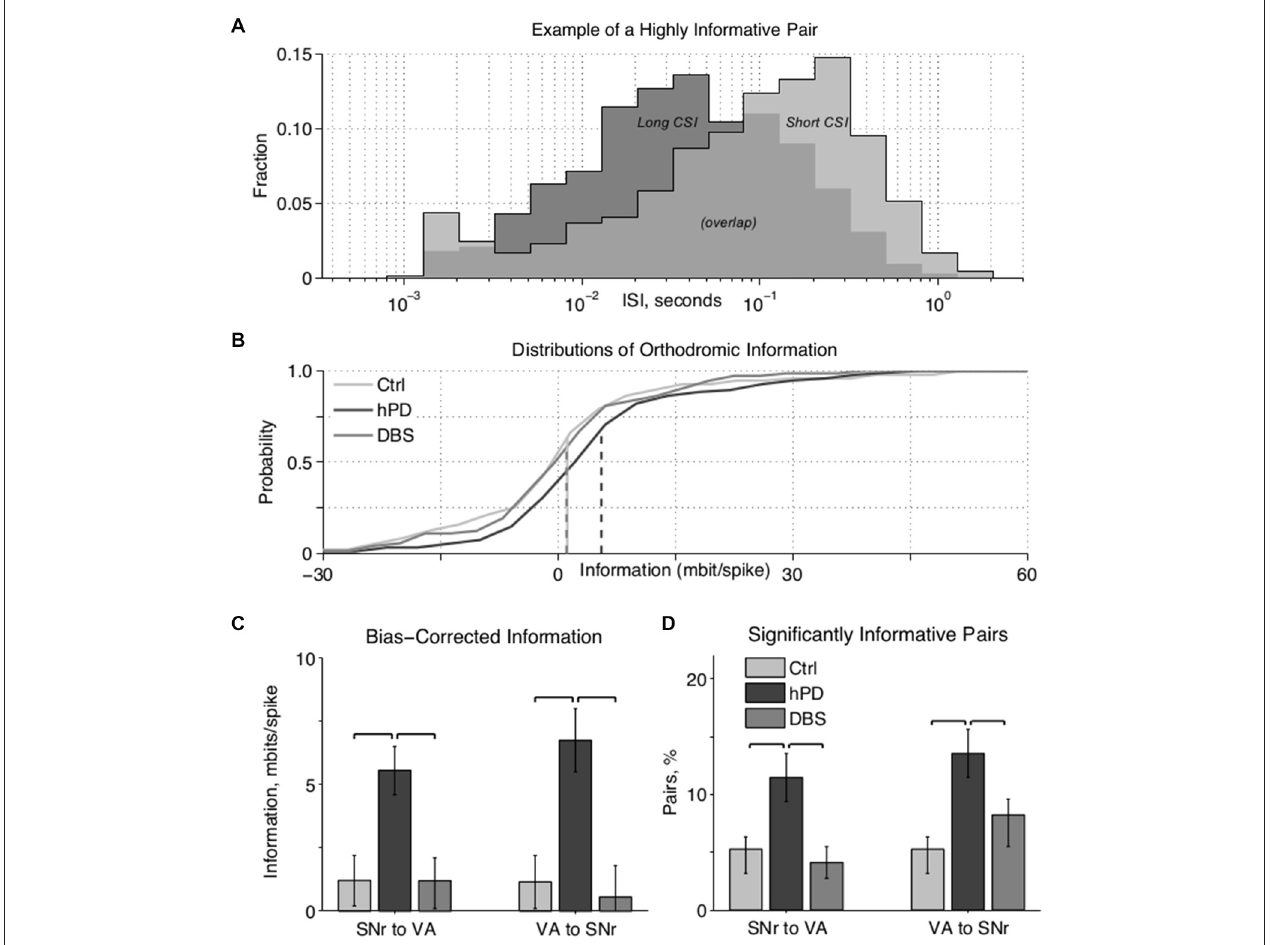
the distribution has a substantially greater median and mean, indicating that many pairs do transmit information. (C) Bias-corrected information between all pairs in both directions, mean ± 50% c.i. Directed information was increased by hPD induction, and decreased by therapeutic STN-DBS; significance noted with black overscores ( p bca < 0.05). (D) Percentage of pairs in each condition transmitting significant information quantified as at least 1.645 standard deviations (i.e., p < 0.05) above 0, percentage ± 50% c.i. More pairs transmitted significant information in the hPD compared to the other conditions; significance noted with black overscores ( p bca <